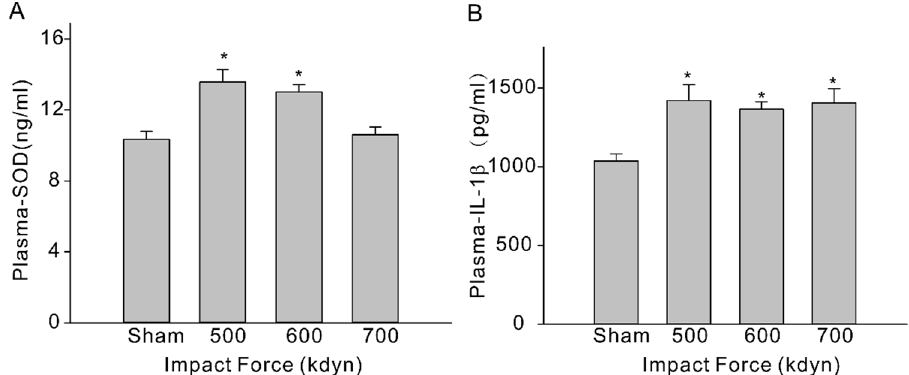
Figure 3. Plasma SOD ( A ) and IL-1 β ( B ) levels in sham and mTBI mice. Plasma were collected at 2-h time-point after the impact, and samples were analyzed via ELISA. Data are presented as mean ± SEM. * p < 0.05 compared to sham.